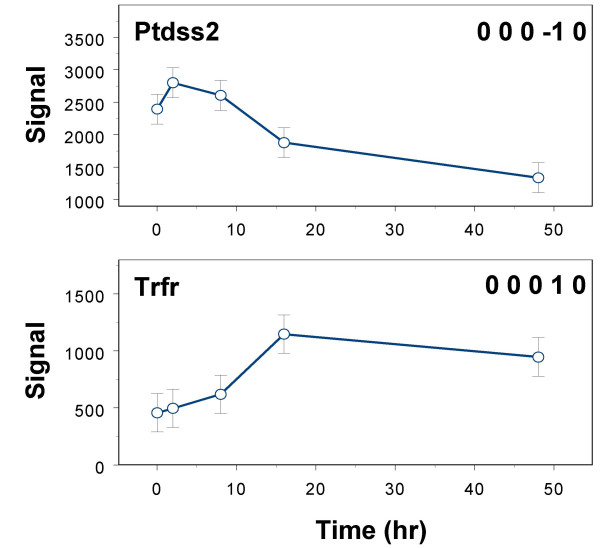
Example diagrams to illustrate expression pattern of genes in Class III. Expression patterns of genes Ptdss2, and Tfrc from Class III, which are unchanged at 2 hr and 8 hr, were first significantly altered at 16 hr after OBX, and each had a different fluctuation index.